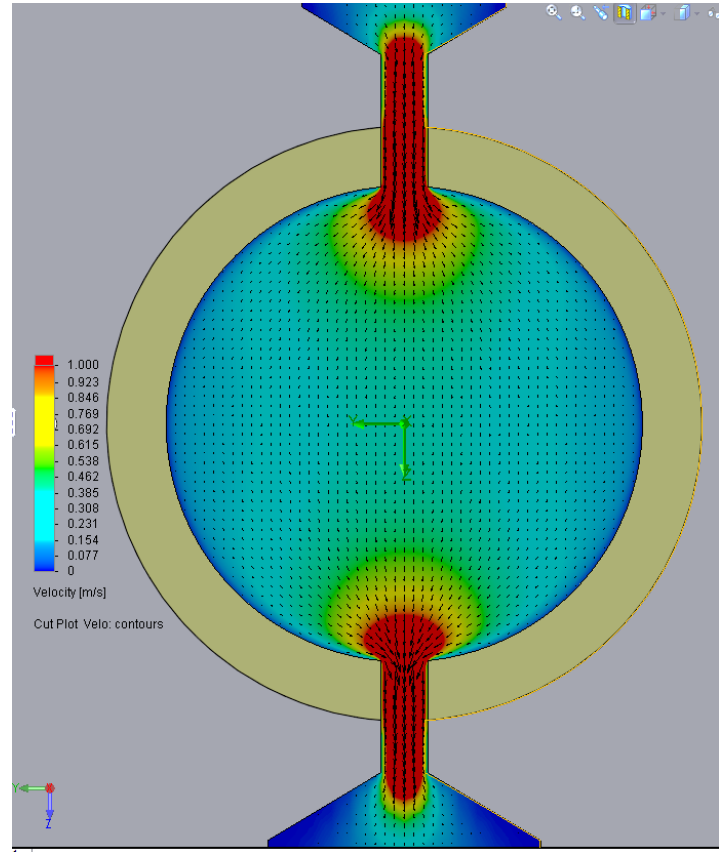
Figure 15. CFD simulation of sensor fluidic structure displaying the flowing velocity of the lubricant normalized to 1 m/s.